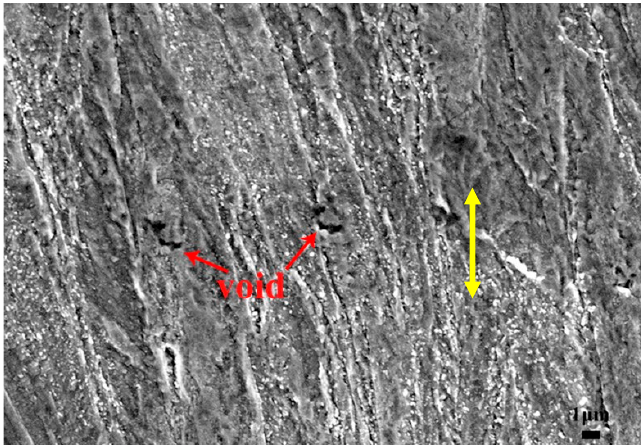
Figure 7. Microstructure of the sample after creep rupture for the stress of 160 MPa near the fracture. (The yellow arrow denotes the direction of the applied load.)